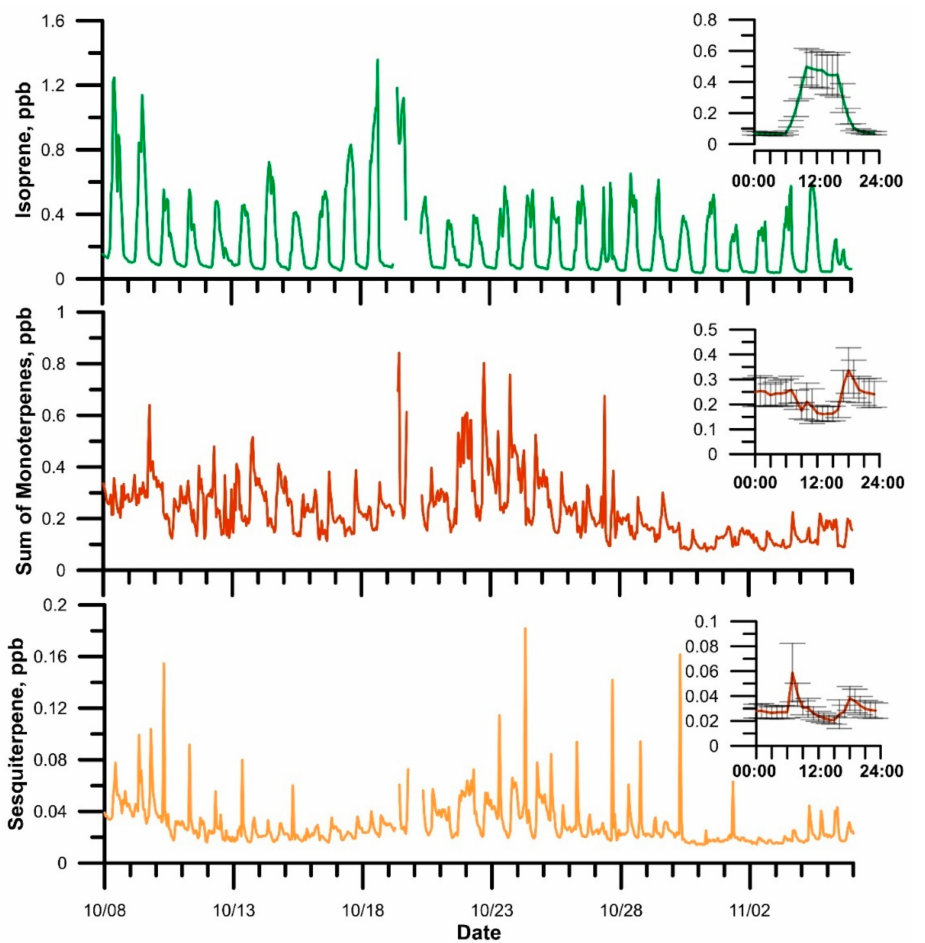
Figure 1. Time series and average diurnal (inset) profile of isoprene, monoterpene, and sesquiterpene. The daytime (nighttime) mean concentration of isoprene, monoterpene and sesquiterpene were 0.44 ± 0.20 (0.07 ± 0.02), 0.18 ± 0.07 (0.25 ± 0.10), and 0.02 ± 0.01 (0.03 ± 0.01) ppb, respectively. The